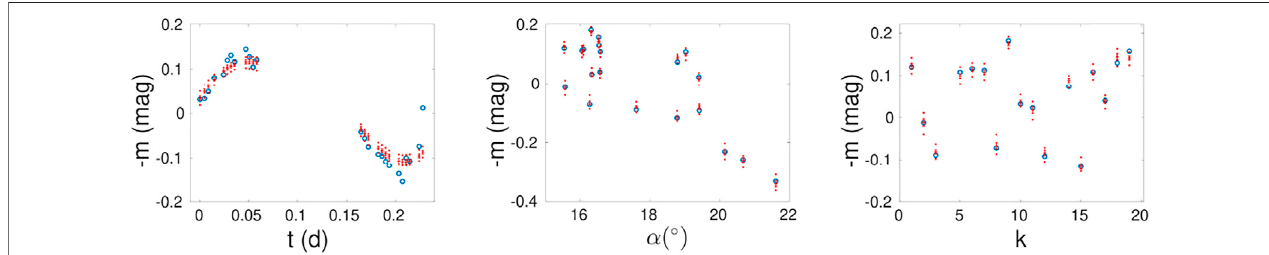
FIGURE 2 | Example photometric lightcurves for asteroid (167) Urda (blue circles) on the magnitude scale. We show the ground-based dense lightcurve #8 (left) and the Gaia sparse lightcurve (middleandright).Redcrossesstand forthebest- fi tconvex modellightcurves withthe1- σ uncertainties(redbars),and theredpoints are the uncertainty envelopes using 5,000 MCMC sample solutions. The symbols t , α , and k denote the time, phase angle, and lightcurve observation